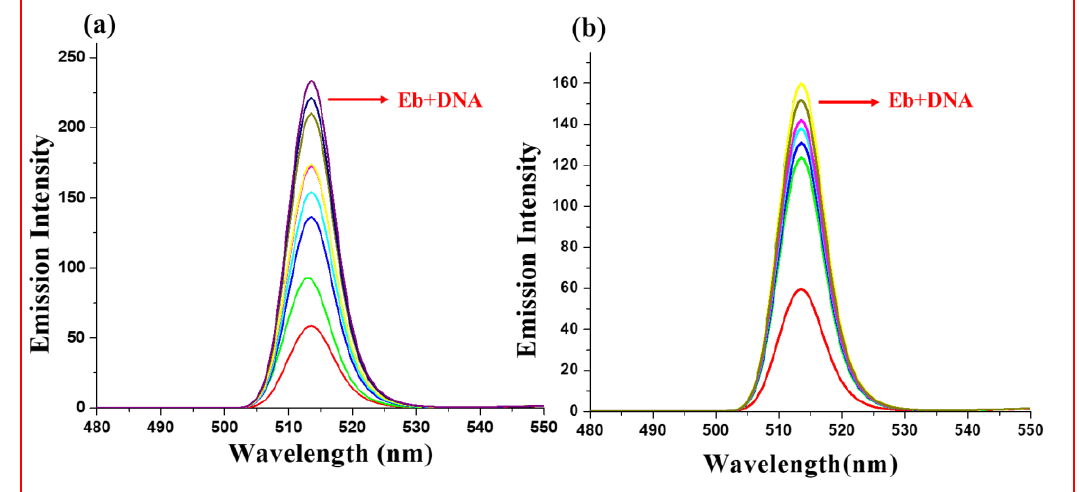
Figure 8. Emission spectra of ( a ) GO-NCD- 1 and ( b ) GO-NCD- 2. Circular dichroism spectroscopy was employed to diagnose the variation in the secondary structure of ct-DNA upon its interaction with nanocomposites. The CD spectrum of ct-DNA gives a maximum at 248 nm and a minimum at 275 nm which are attributed to the base stacking and right-handed helicity of the biomolecule. The spectra of both of the nanoconjugates, GO-NCD- 1 and GO-NCD- 2, were studied with ct-DNA in a 1:1 ratio, and the change in the spectra was observed (Figure 9). The ellipticity values for both the bands changed significantly, suggesting that both of the nanoconjugates interacted with the biomolecule and modified the DNA secondary structure [34].